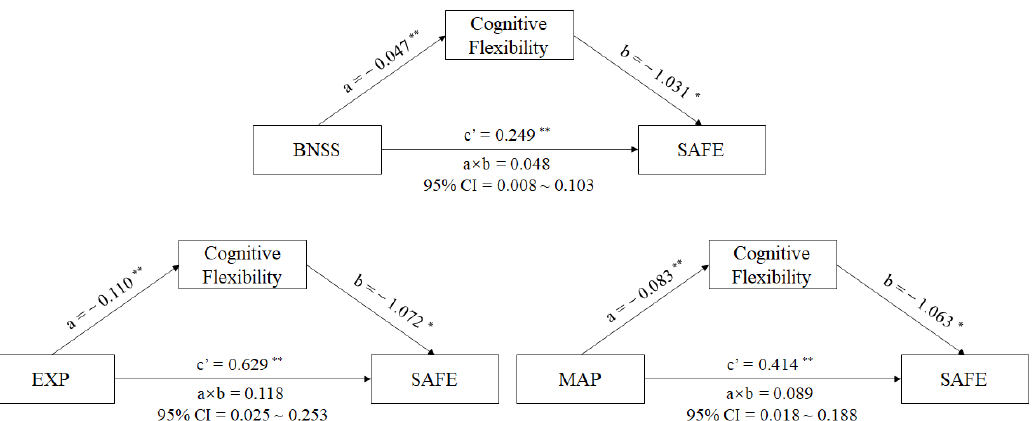
Figure 2. Mediating effects of cognition on the relationship between negative symptoms and social functioning in schizophrenia patients. Note: Path a is independent variable (X) → mediator (M). Path b is mediator (M) → SAFE score (Y), adjusted for X. Path c ’ is X → SAFE score (Y), adjusted for M. Path a × b is X → Y through M. * p < 0.01. ** p < 0.001. Abbreviations: BNSS = The Brief Negative Symptoms Scale, MAP = the motivation and pleasure deficit, EXP = the expressivity deficit, SAFE = Social Adaptive Functioning